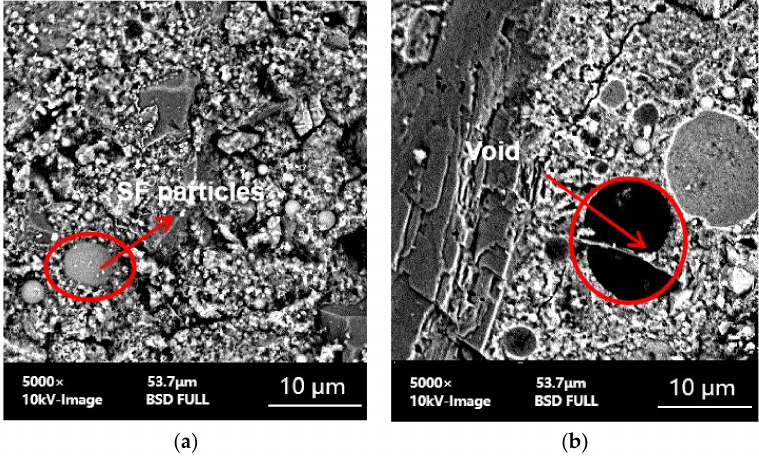
Figure 12. SEM images of UHPC based on composite cementitious material: ( a ) A1, ( b ) A3.